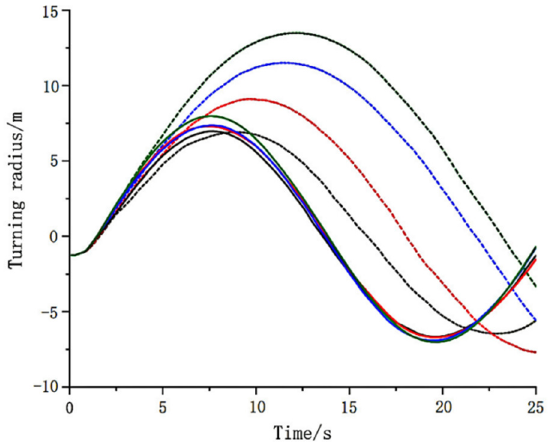
Figure 10. Horizontal displacement curve of the ratooning rice harvester. Note: the dotted line refers to group I chassis and the solid line refers to group II chassis; the same color curve represents the same track motion parameters.